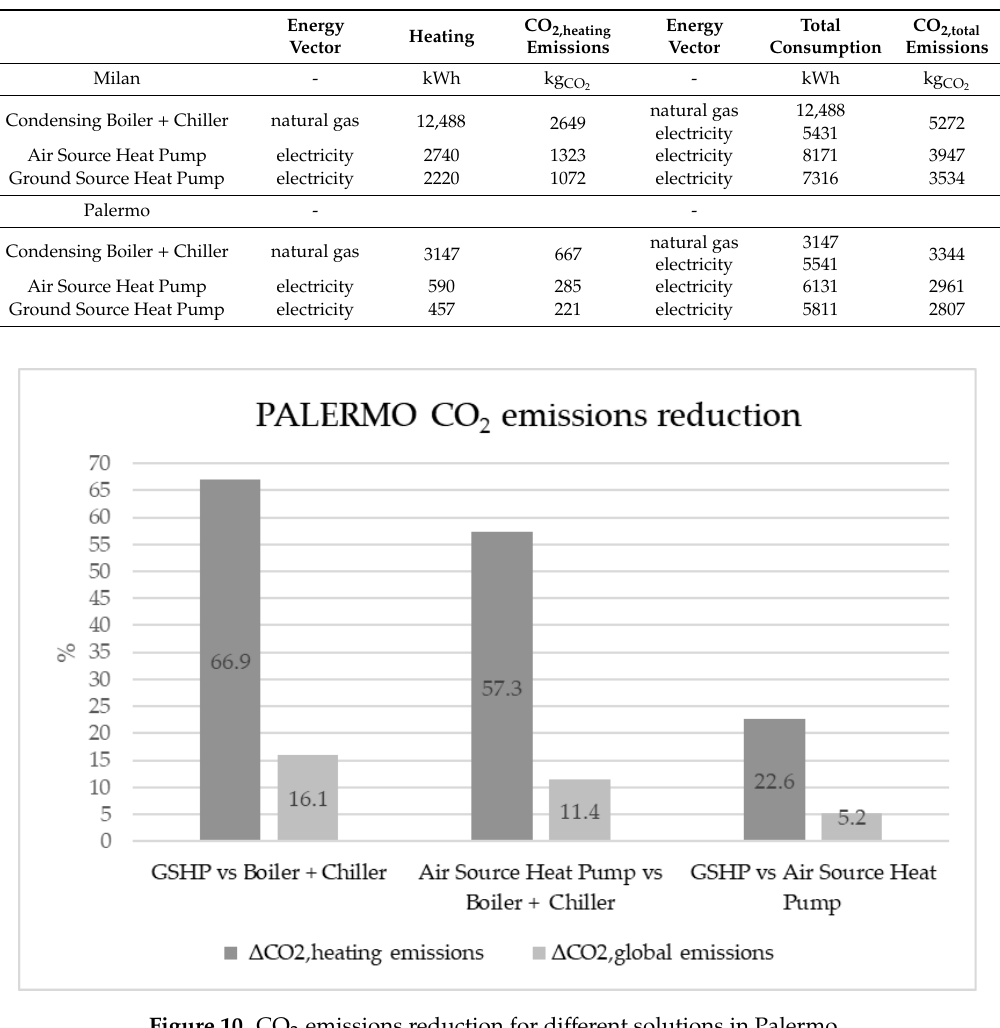
Figure 10. CO 2 emissions reduction for different solutions in Palermo.